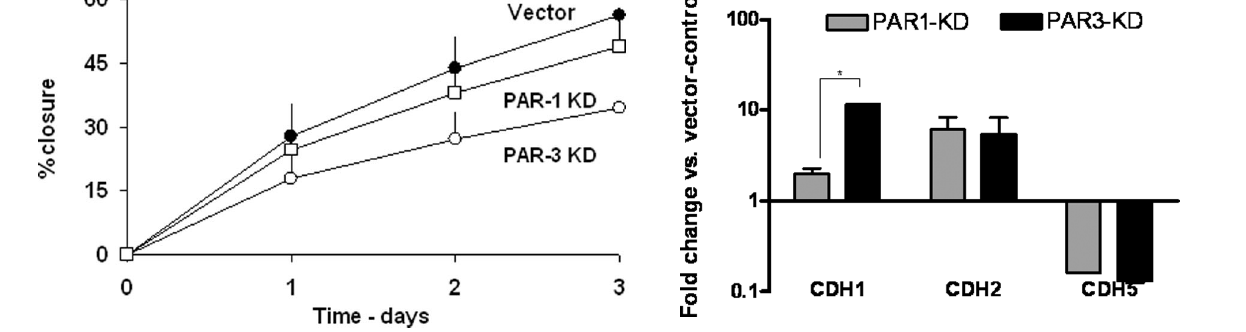
Figure 3. The effects of PARs knockdown on wound closure on wound closure kinetics. Vector control and the desired PARs knockdown cells were seeded at approximately 80% density. The kinetics of wound closure were performed as described in Methods. The results represent mean 6 SE of 5 independent experiments performed in triplicates. P , 0.05 for Vector vs. PAR-3 KD and . 0.05 vs. PAR-1 KD.